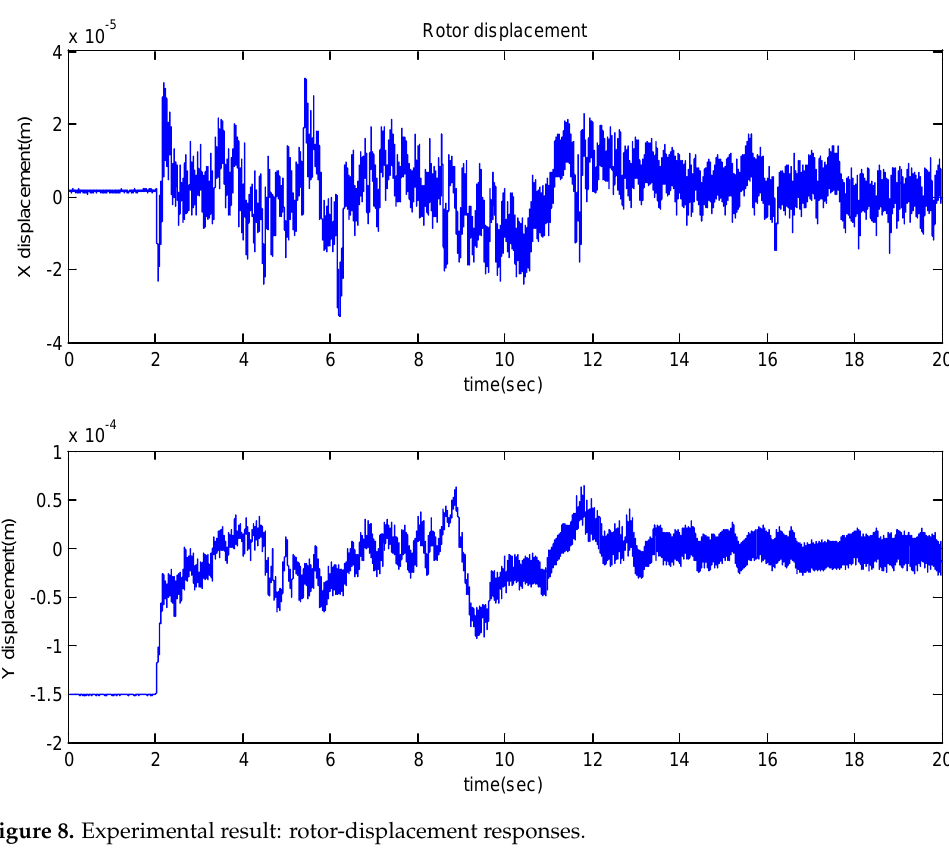
Figure 8. Experimental result: rotor-displacement responses.